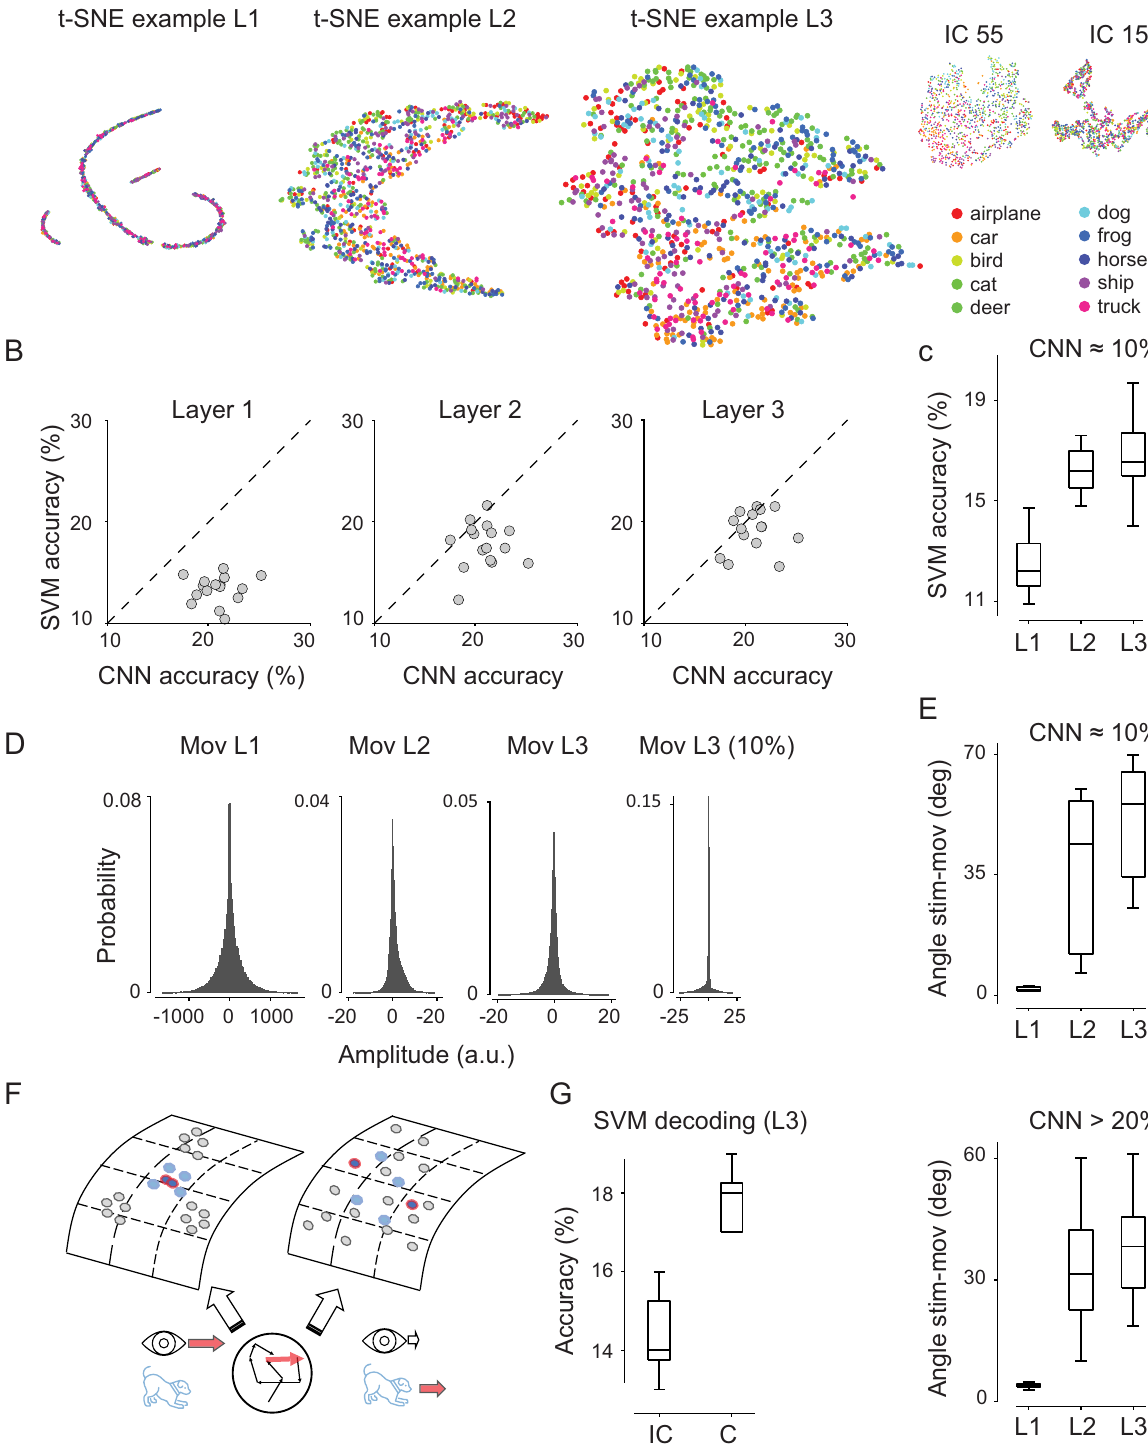
Fig 3. Eye-movement inputs support the clustering of object-class representations. (A) Representative example of t-SNE embedding for visual inputs only, and for a network that attained above chance-level classification performance with saccadic visual shifts and congruent movement inputs. Color hue indicated a spatial gradient for object classes (legend) in layers 2 and 3. Top-right plots, representative networks trained with incongruent movements (IC) and end-stopped at 15 or 55 epochs. (B) Accuracy of SVM models trained on t-SNE representations as a function